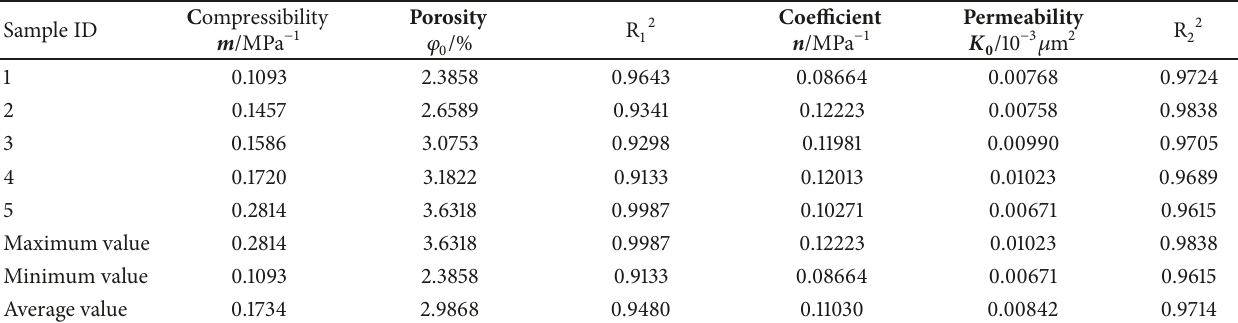
Table 2: Statistic analysis results of the relationships of the porosity and permeability of shale with the effective stress. Sample